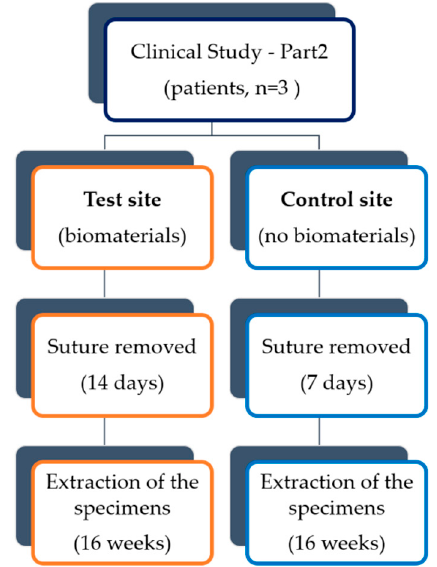
Figure 1. Flow chart of the clinical study.